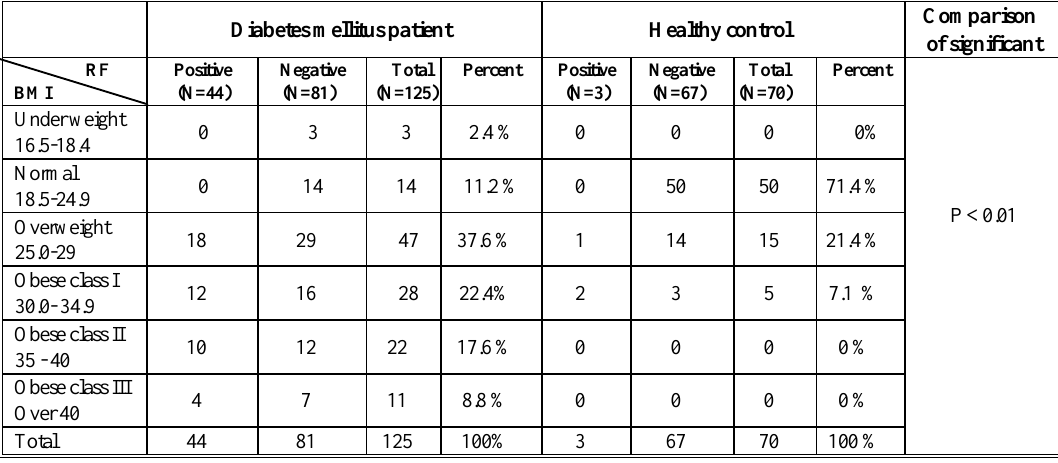
Table 2: Comparison of diabetic patients with healthy control who have RF positive and negative according to body mass index BMI (kg/m 2